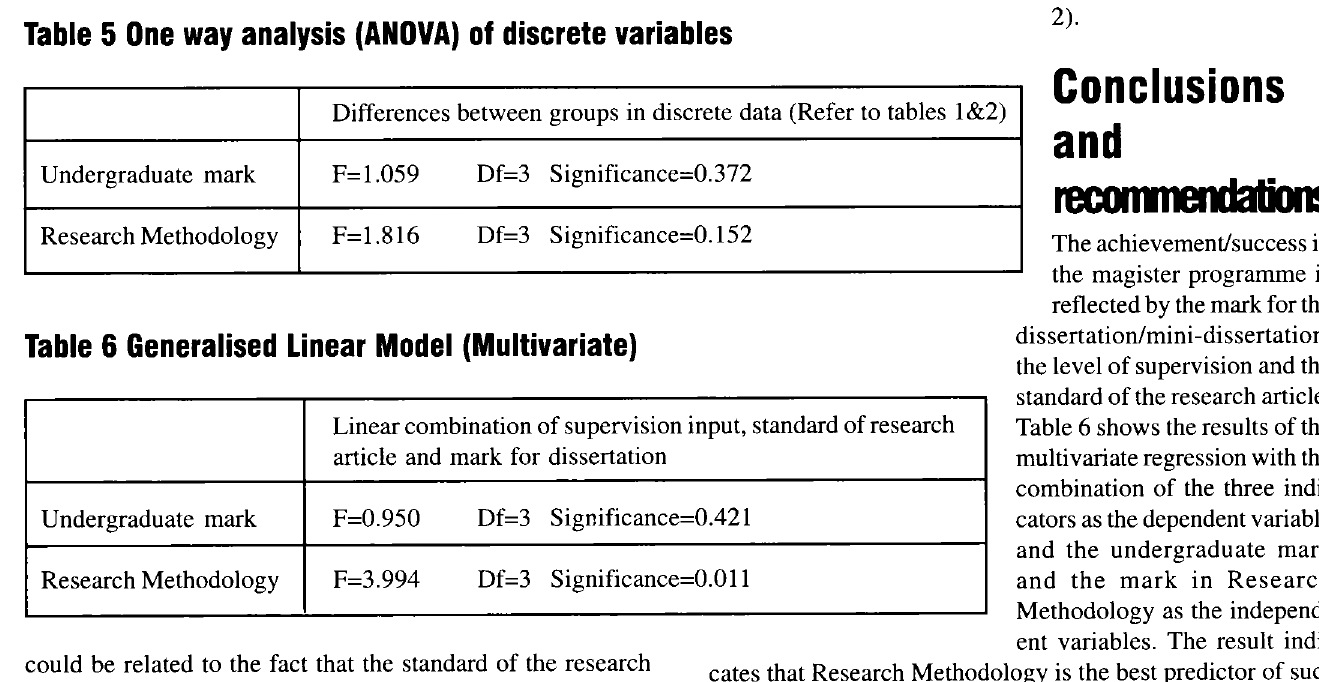
Table 5 One way analysis (ANOVA) of discrete variables